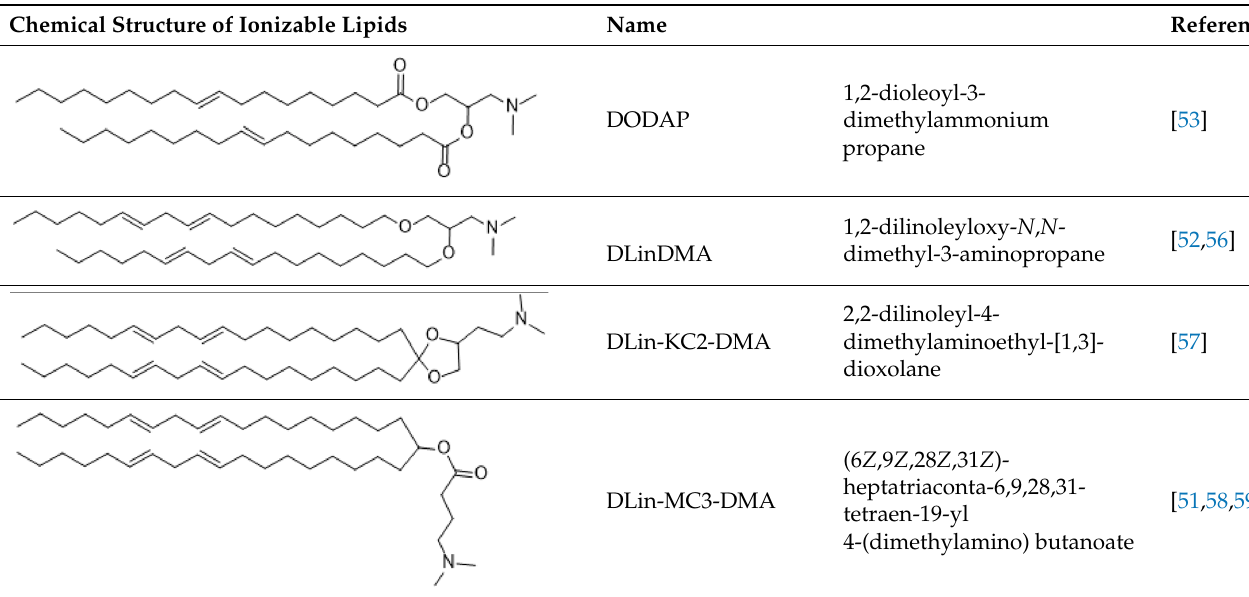
Figure 2. Chemical structure of DODAP, a cationic ionizable lipid. Table 2. Chemical structures and names of ionizable lipids.